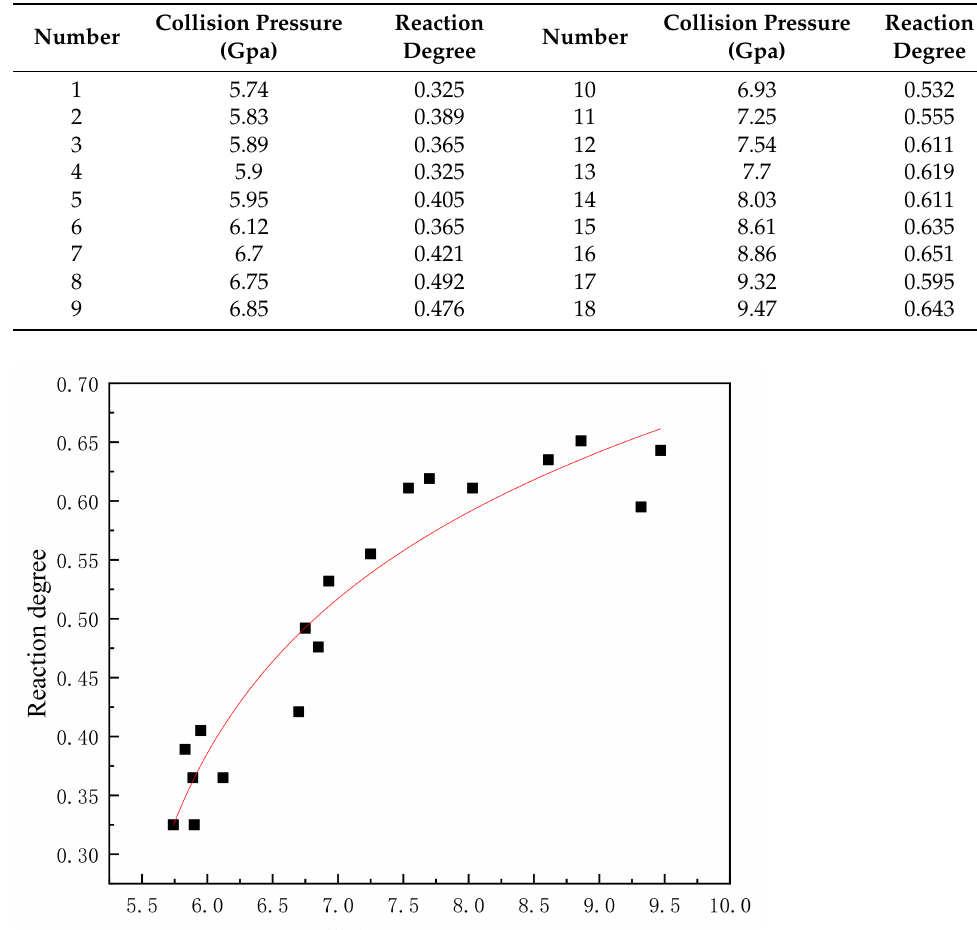
Figure 3. The corresponding relationship between collision pressure and reaction